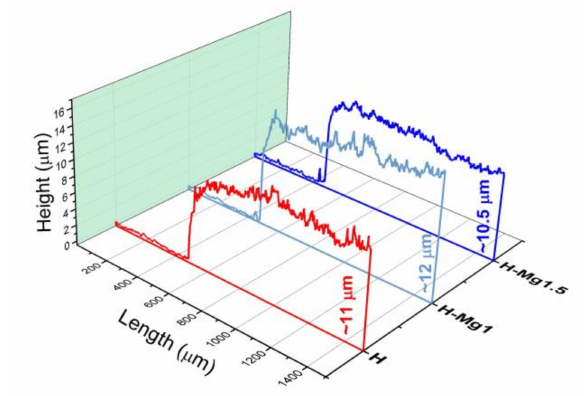
Figure 7. Coating